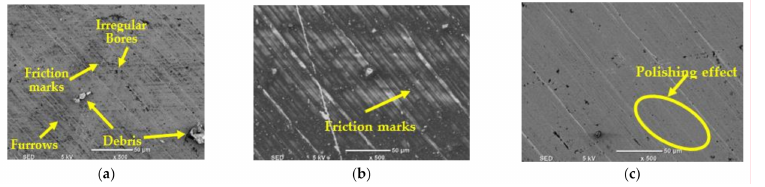
Figure 12. SEM of machined surface under different cooling conditions ( a ) dry, ( b ) MQL, and ( c ) MQL + Al 2 O 3 nanoparticles at cutting speed = 50 m/min and feed rate = 100